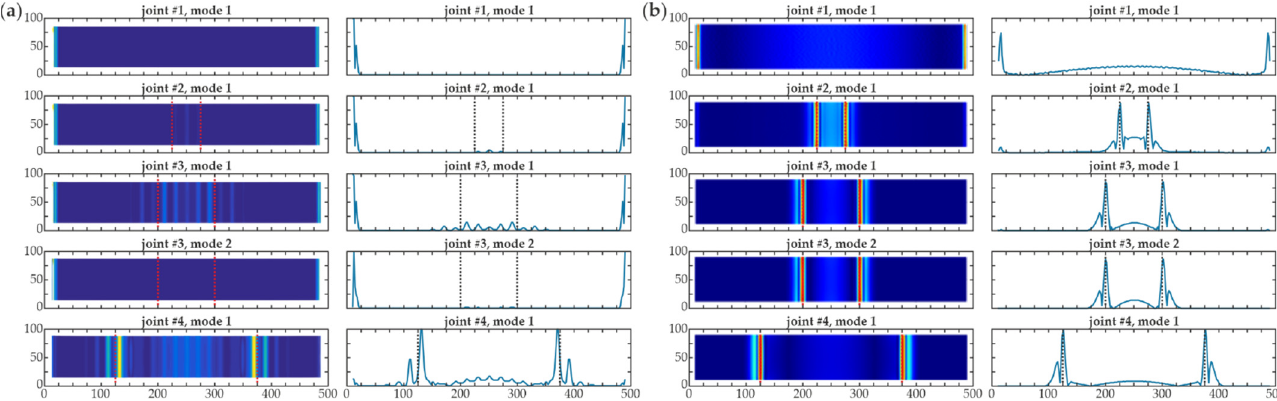
Figure 5. Influence of boundary effect to damage imaging (numerical results mesh 2 mm, no additional interpolation) for all joints #1–#4 (dimensions in [mm]) — map and central cross section: ( a ) continuous wavelet transform (CWT) without extrapolation, wavelet gaus4 , s = 2; ( b ) CWT with extrapolation, wavelet gaus4 , s = 2.